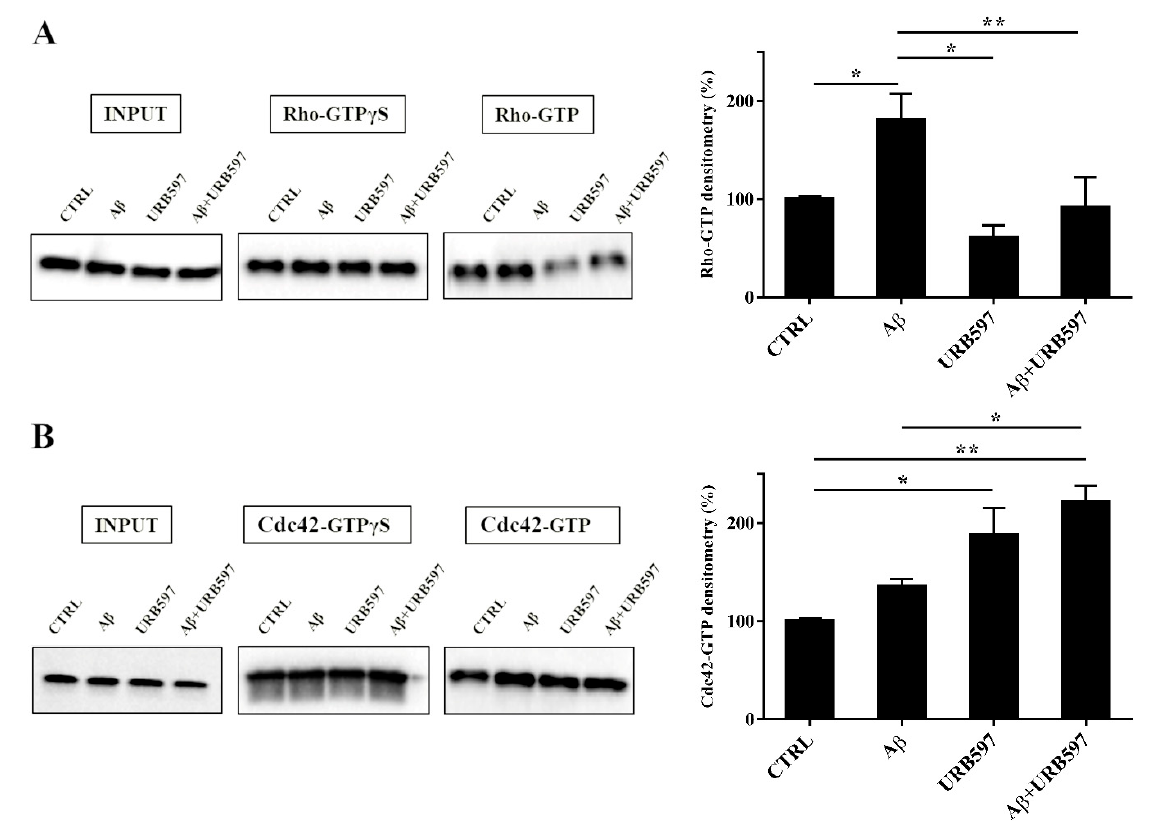
Figure 7. Pull-down assay of Rho and Cdc42 proteins ( A,B ). BV-2 cells were pre-treated with 5 µM URB597 for 4 h and incubated with 30 µM A β 25–35 for 24 h. The pull-down assay with GTP γ S was used as positive control. The results are reported as a percentage versus control (CTRL). Densitometric analyses were performed with ImageLab software (Biorad) and normalized to INPUT. * p < 0.05, ** p < 0.01.